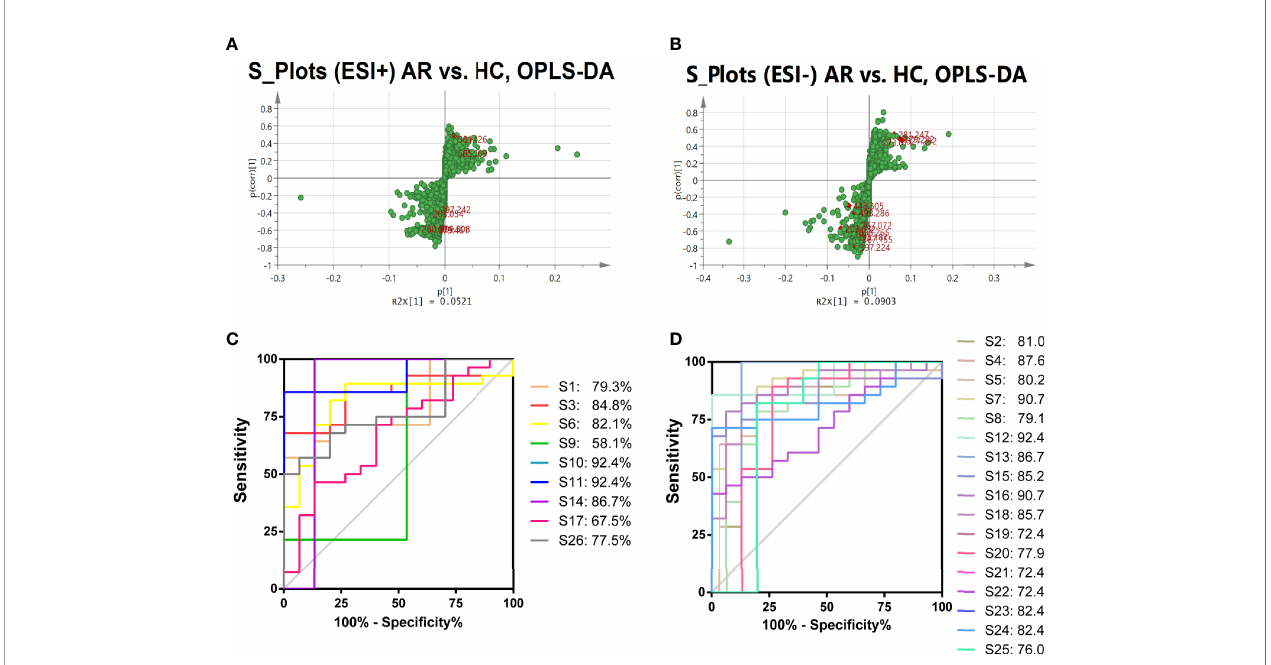
FIGURE 6 | Identi fi cation of the Differential Metabolites in Serum. A-B, OPLS-DA S-plots of metabolomic analysis based on serum samples in ESI+ mode (A) and in ESI- mode (B) . The predictive ROC curves generated using 26 candidate biomarkers contributing to AR progress. (C) C AR >C HC ; (D) C AR <C HC